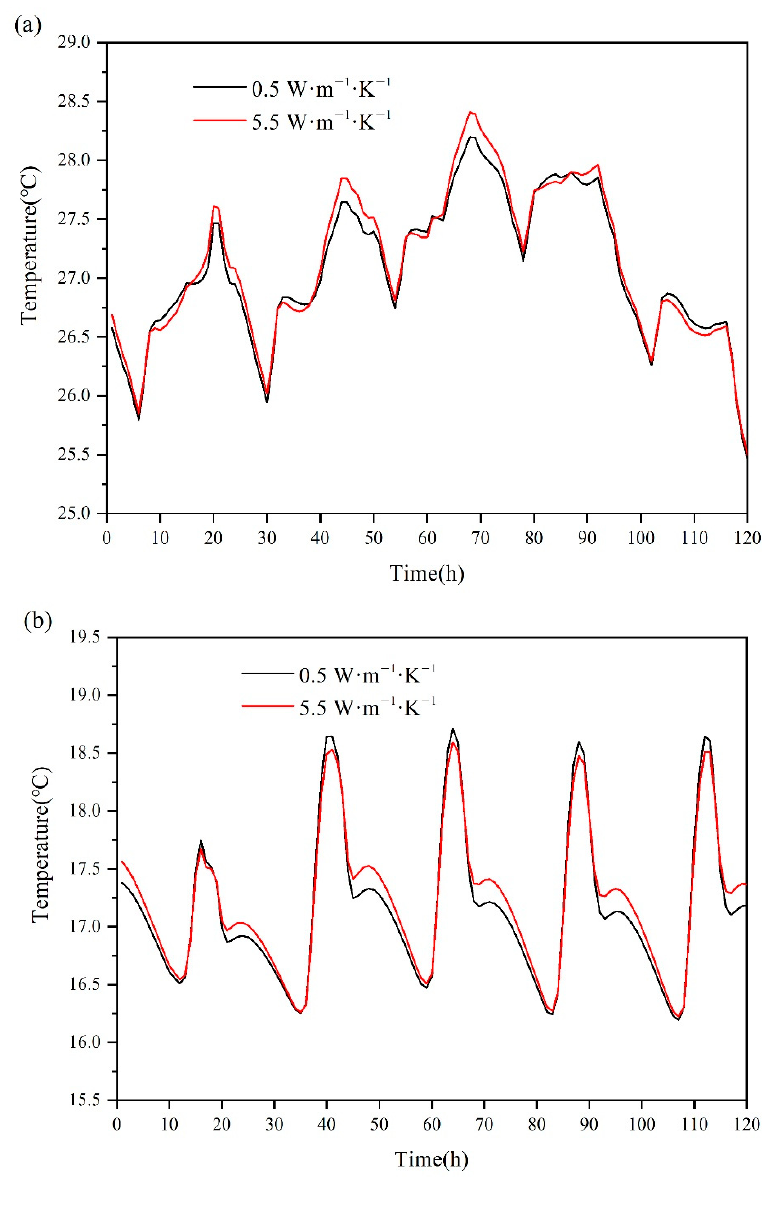
Figure 9. ( a ) The inner surface temperature history of the roof from 6 July to 10 July; ( b ) the south wall from 21 January to 25 January.